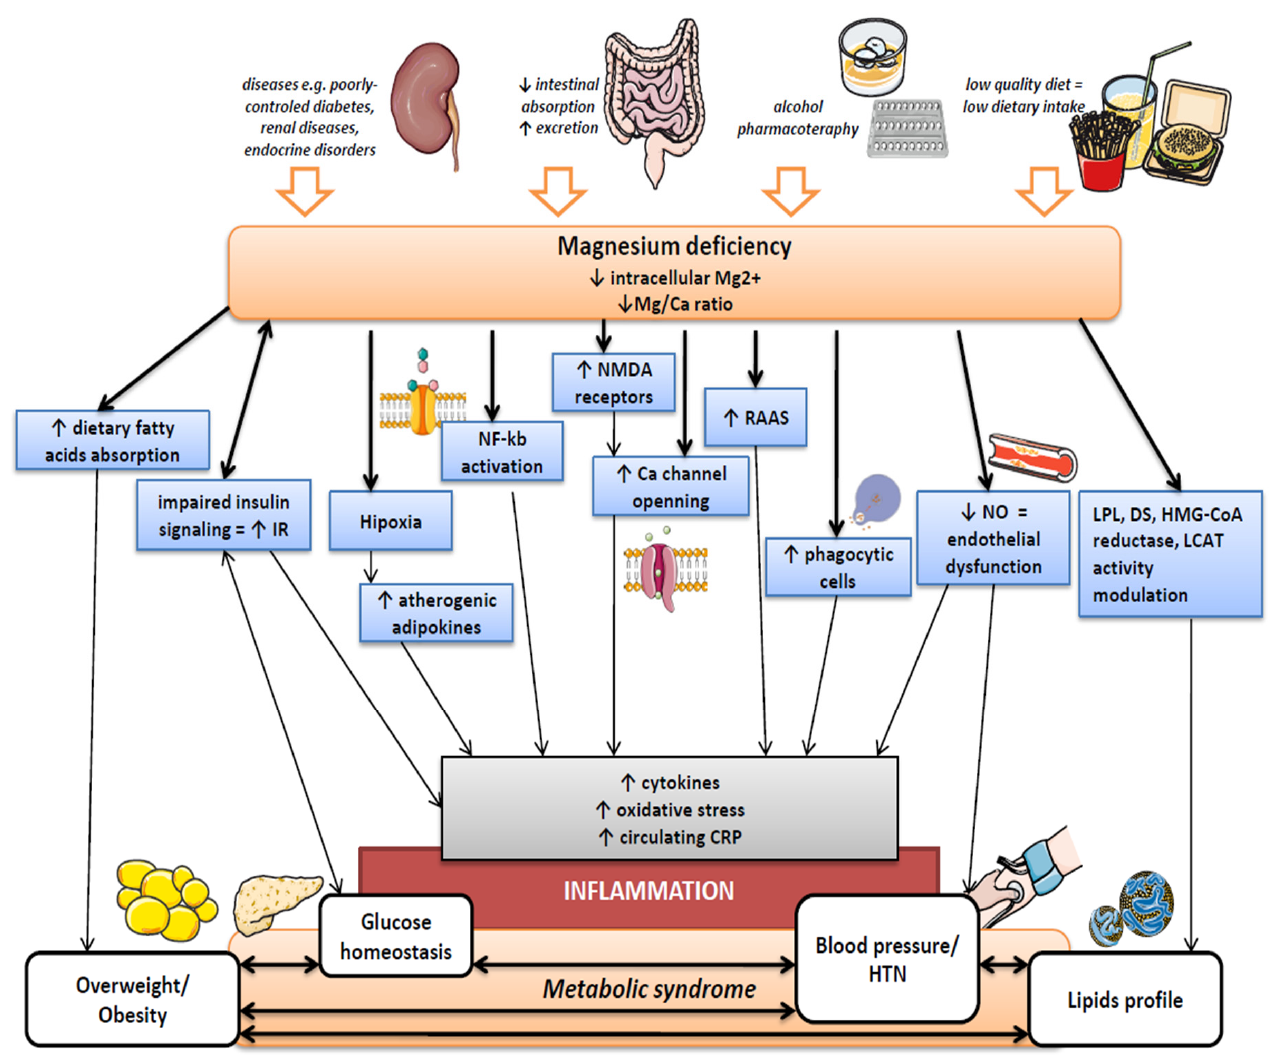
Figure 2. Influence of Mg deficiency on metabolic disorders. Abbreviations: Ca, calcium; CRP, C-reactive protein; DS, desaturase; HMG-CoA, β -hydroxy β -methylglutaryl-CoA; HTN, hypertension; IR, insulin resistance; LCAT, lecithin-cholesterol acyl transferase; LPL, lipoprotein lipase; Mg, magnesium; NF-kb, nuclear factor kappa-light-chain-enhancer of activated B cells; NMDA, N-methyl- D-aspartate; NO, nitric oxide; RAAS, renin-angiotensin system. This figure was made using the Ser- vier Medical Art collection (http://smart.servier.com/) (accessed on 25 March 2022).